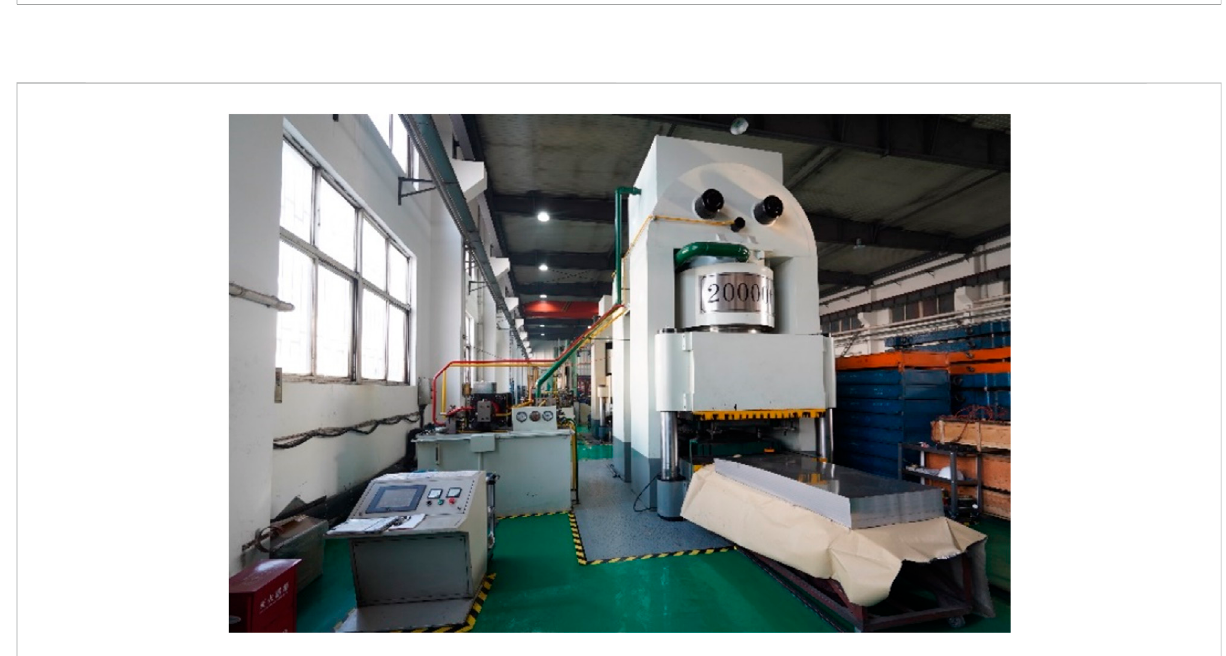
FIGURE 13 A 20 MN double frame press